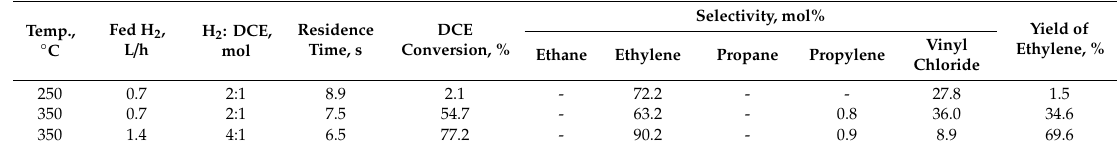
Table 12. Influence of di ff erent parameters on results of 1,2-dichloroethane hydrodechlorination using a catalyst containing 2% Ni and 2% Mo on microspheric alumina.